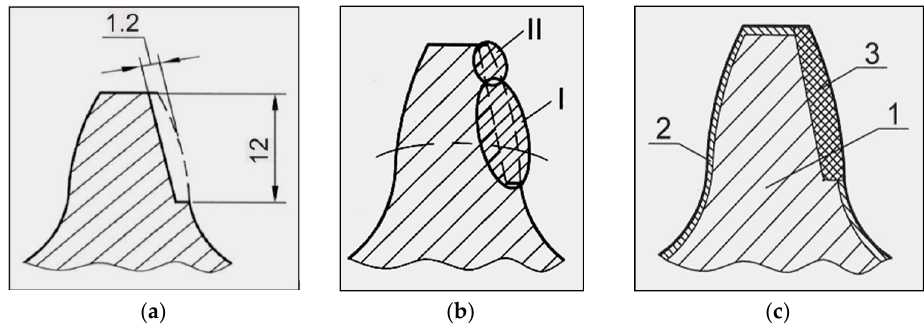
Figure 2. Schematic presentation of the tooth: ( a ) prepared for hard-facing; ( b ) hard-faced in two passes (I—the first pass, II—the second pass); ( c ) cross-section after the hard-facing and machining: 1—tooth core, 2—cemented layer, 3—hard-faced portion.